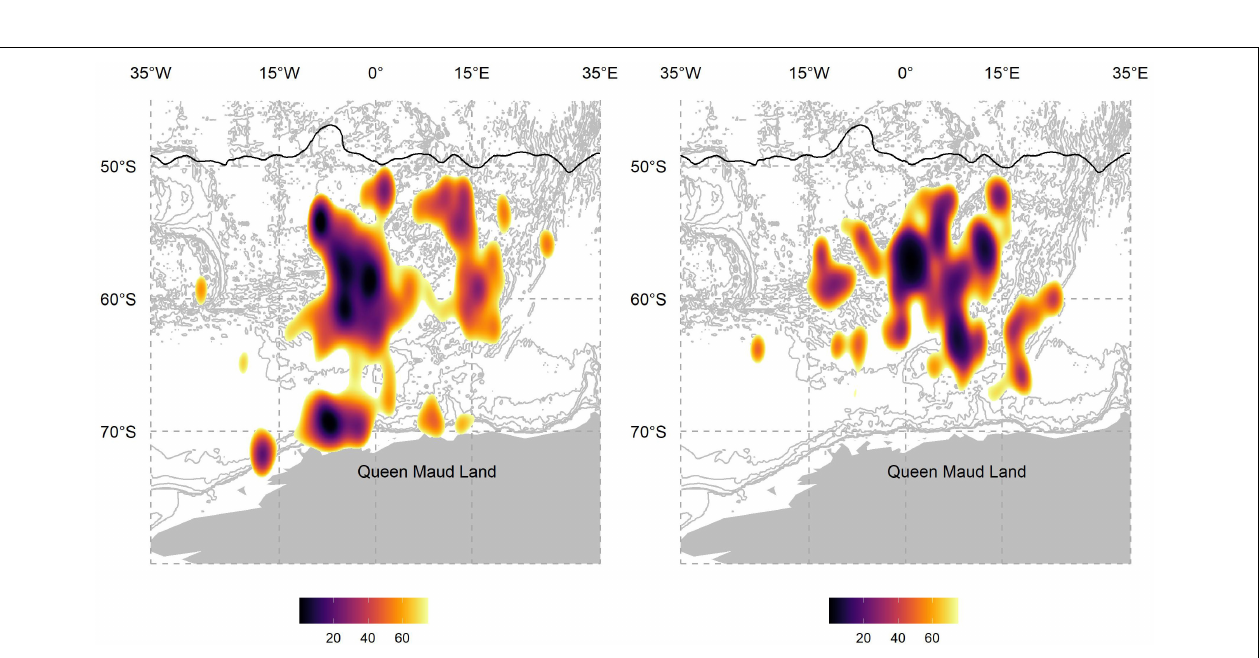
Frontiers in Marine Science |